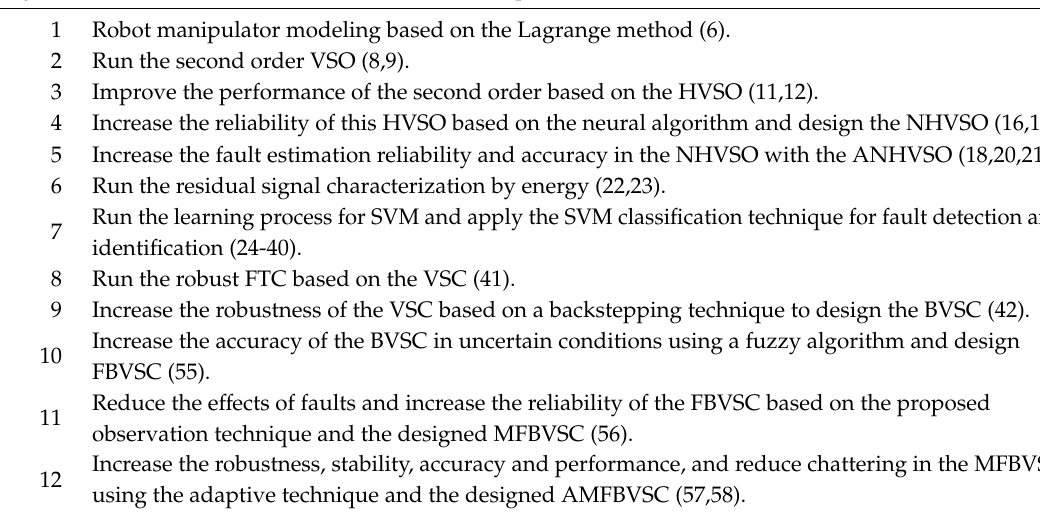
Algorithm 1. Support vector machined (SVM)-based adaptive neuro variable structure observer for fault diagnosis and fault-tolerant control of the robot